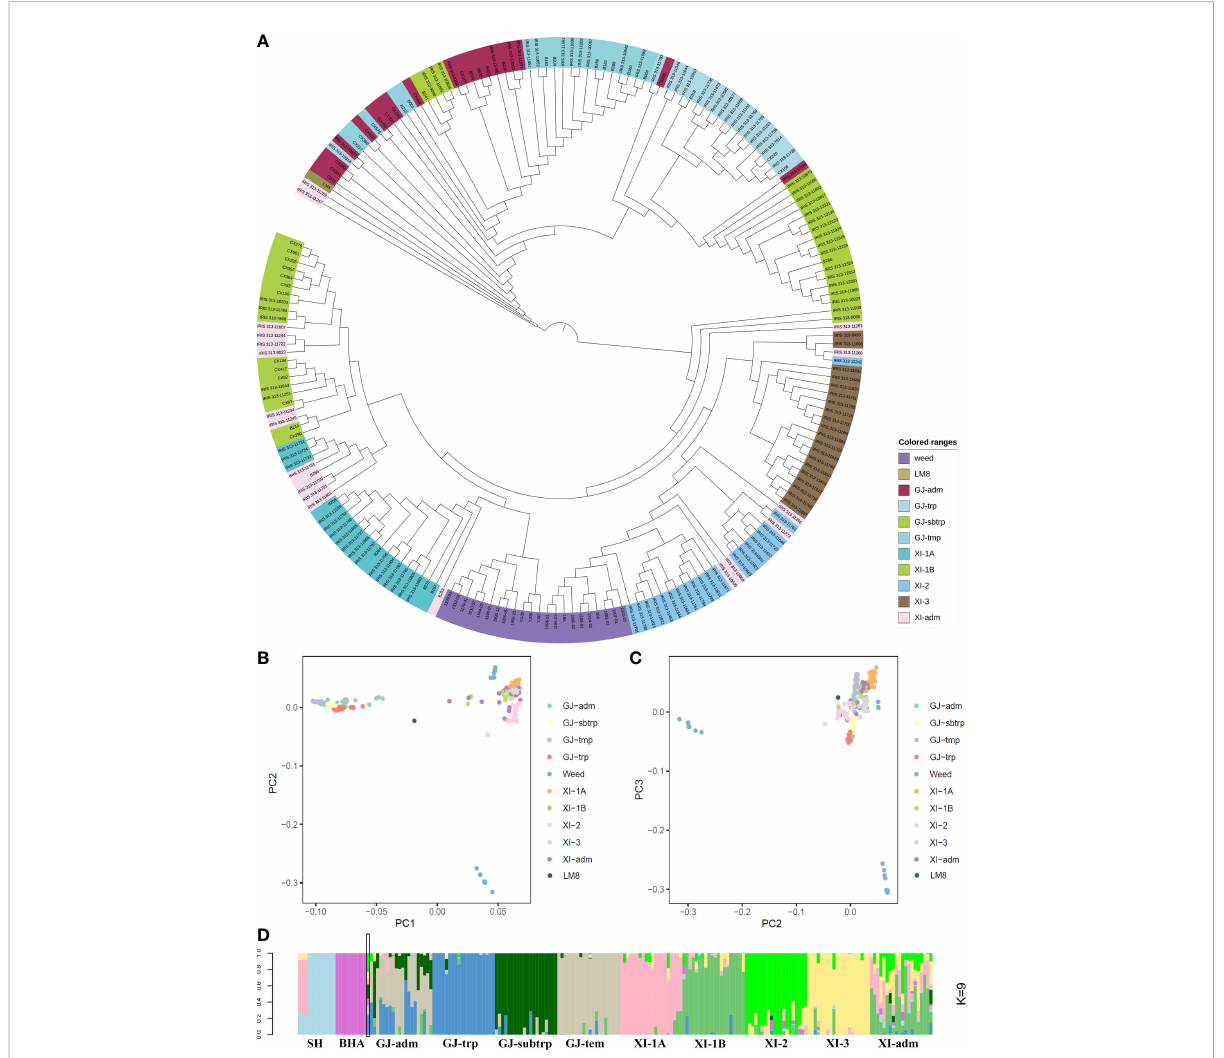
FIGURE 1 Subpopulation classi fi cation of LM8. LM8 was classi fi ed and its population structure was determined via an analysis of genome-wide SNPs in 203 cultivated and weedy rice lines. (A) Maximum-likelihood phylogenetic tree. (B – C) Principal component analysis. (D) Genetic proportions calculated using STRUCTURE ADMIXTURE ( K = 9). GJ and XI represent the O. sativa groups japonica and indica , respectively. As described by Wang et al. (2018), GJ-adm and XI-adm represent admixture components within japonica and indica . Additionally, GJ-trp, GJ-sbtrp, GJ-tmp, XI-1A, XI-1B, XI-2, and XI-3 represent Southeast Asian tropical, Southeast Asian subtropical, primarily East Asian temperate, East Asia, modern varieties of diverse origins, South Asia, and Southeast Asia,